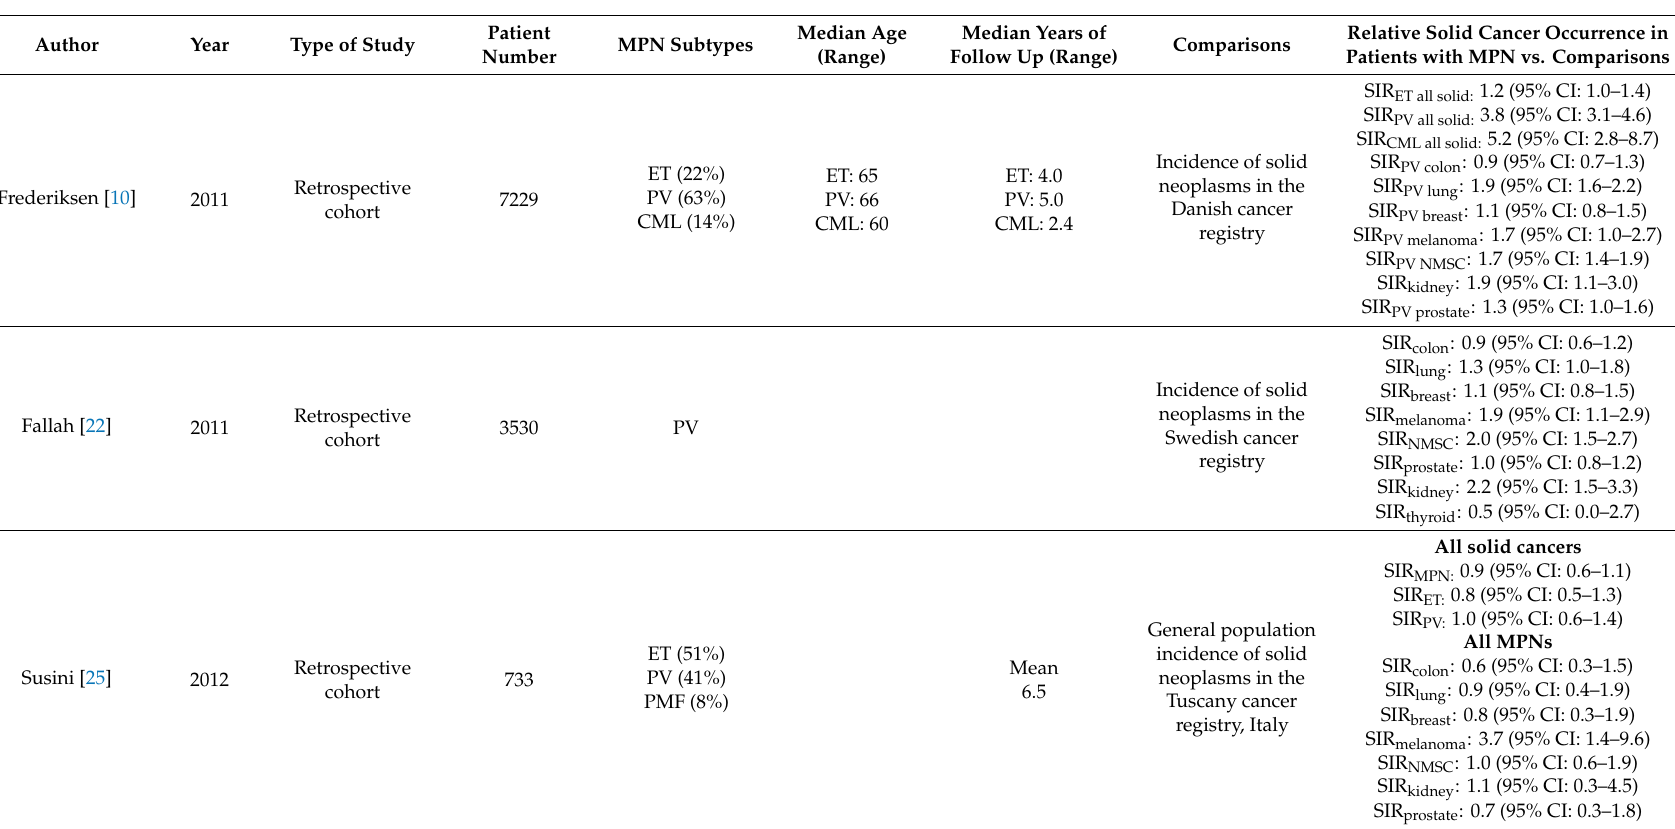
Table 1. Studies on the incidence of solid cancers in patients with chronic myeloproliferative neoplasms (MPNs) compared to cancer incidence in the general population or matched comparisons.